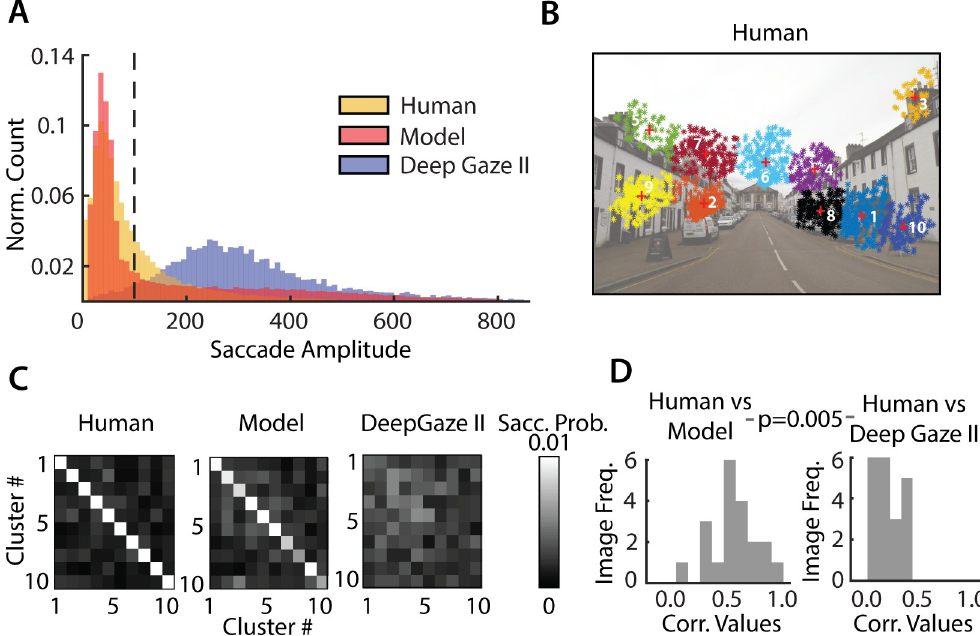
Fig 7. Comparison between human, model and Deep Gaze II performance. A. Distribution of saccade amplitudes for human participants (yellow), sequential probability ratio test (SPRT) model (red) and the Deep Gaze II neural network (blue). B. Top 10 clusters of human fixations, ranked by cumulative fixation duration (rows/columns 1–10). Increasing indices correspond to progressively lower cumulative fixation duration. C. Saccade probability matrix (left) averaged across all images and all participants, (middle) for simulations of the sequential probability ratio test (SPRT) model, and (right) for the Deep Gaze II neural network. D. Distribution, across images, of the correlations (r-values) of saccade probability matrices between human participants and sequential probability ratio test (SPRT) model (left) and human participants and Deep Gaze II neural network (right). p-value indicates pairwise differences in these correlations across n = 20 images.